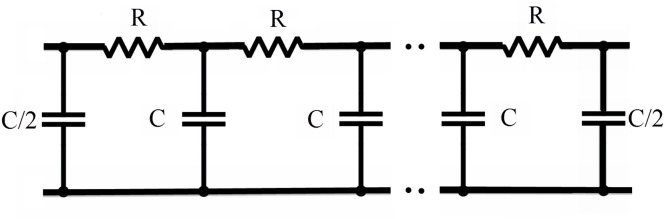
The lumped RC model.